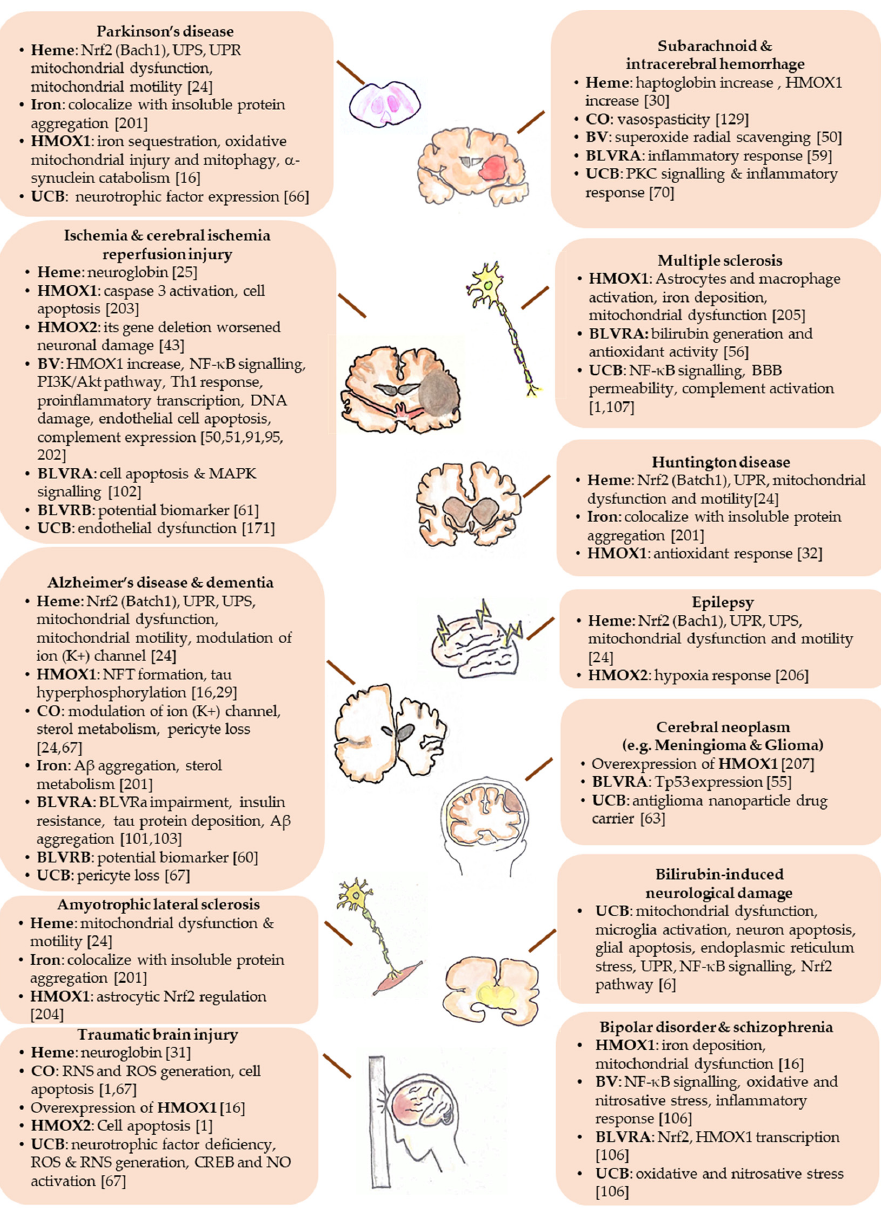
available literature (see References in Figure 2), resuming and connecting the text to Tables 1 and 2. The YPs: A β , amyloid β ; BV, biliverdin; BVR, biliverdin reductase; CO, carbon monoxide; CREB, cAMP-responsive element-binding; HMOX, heme oxygenase; NFT, neurofibrillary tangles; Nrf2, nuclear factor erythroid 2–related factor 2; NF- κ B, nuclear factor kappa-light-chain-enhancer of activated B cells; NO, nitric oxide; ROS, reactive oxygen species; RNS, reactive nitrogen species; UCB, unconjugated bilirubin; UPR, unfolded protein response; UPS, ubiquitin-proteasome system; Tp53, human p53 tumor protein.(For details see [201–207]).